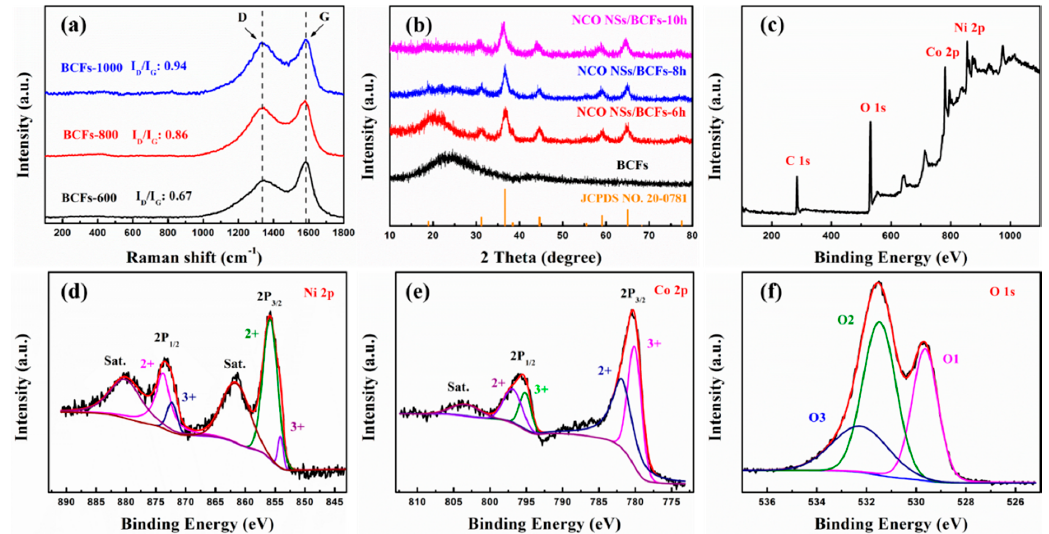
Figure 4. ( a ) Raman spectra of BCFs; ( b ) XRD pattern of NCO NSs/BCFs; ( c ) XPS survey spectra of NCO NSs/BCFs; High-resolution ( d ) Ni 2p; ( e ) Co 2p; ( f ) O 1s XPS spectrum of NCO NSs/BCFs.